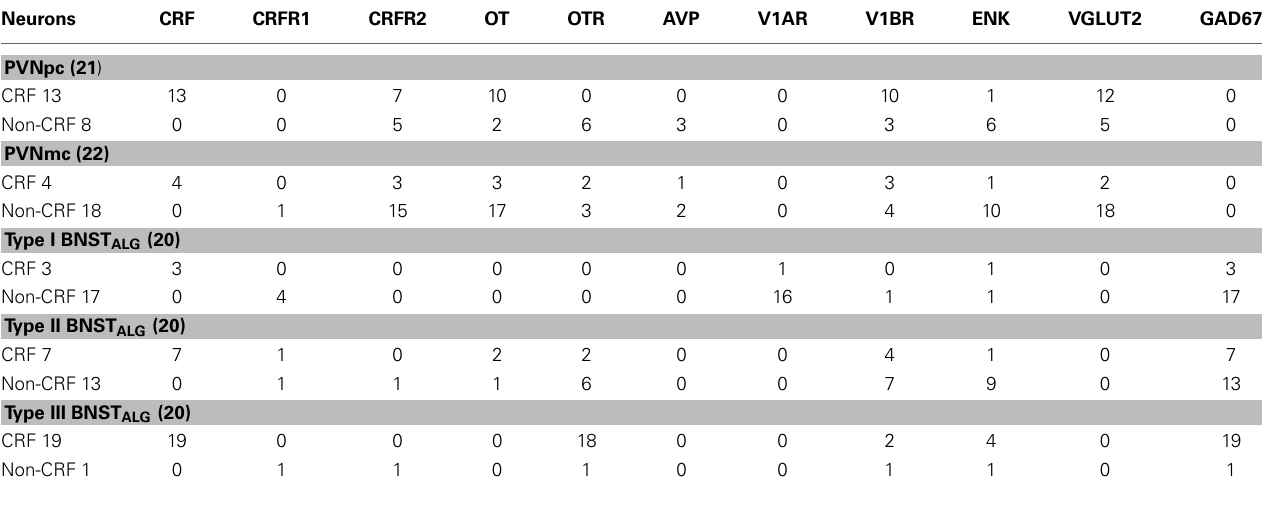
Table 1 | Transcriptomic analysis of CRF, non-CRF PVN cells, and Type I–III BNST ALG neurons. Neurons CRF